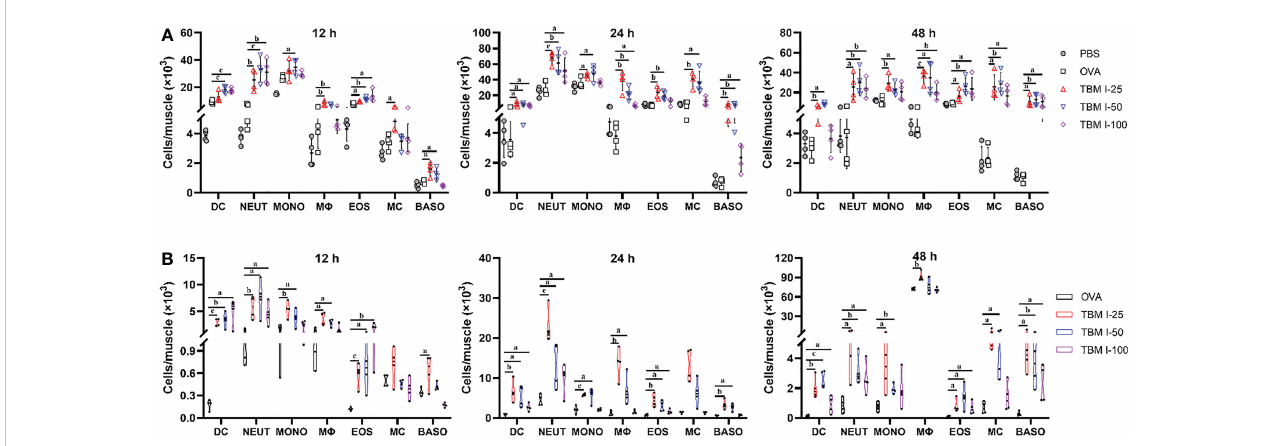
FIGURE 5 TBM I promoted the recruitment and antigen uptake of immune cells at the injection site. Mice were injected i.m . with OVA-AF488 alone or adjuvanted with TBM (I) The quadricep muscle tissues were collected at the indicated time points and subjected to FCM. (A) The number of immune cells recruited into the quadricep muscles at 12, 24, and 48 hpi. (B) The number of Ag + immune cells recruited into the quadricep muscles at 12, 24, and 48 hpi. The data are presented as means ± SD ( n = 4). a P < 0.05, b P < 0.01, and c P < 0.001 vs OVA-AF488. DC, dendritic cell; NEUT, neutrophil; MONO, monocyte; M F , macrophage; EOS, eosinophil; MC, mast cell; BASO,